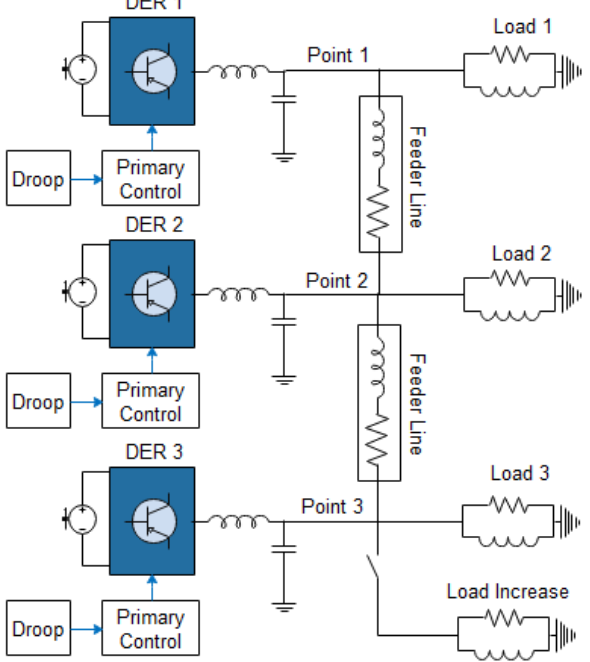
Figure 3. Investigated Decentralized Islanded Microgrid.